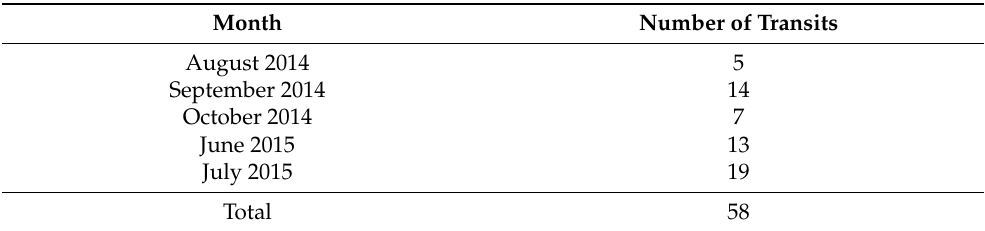
Table A6. Sušac–Lastovo passage—number of cruise ships’ transits in selected high-risk navigational and environmental locations (passages).